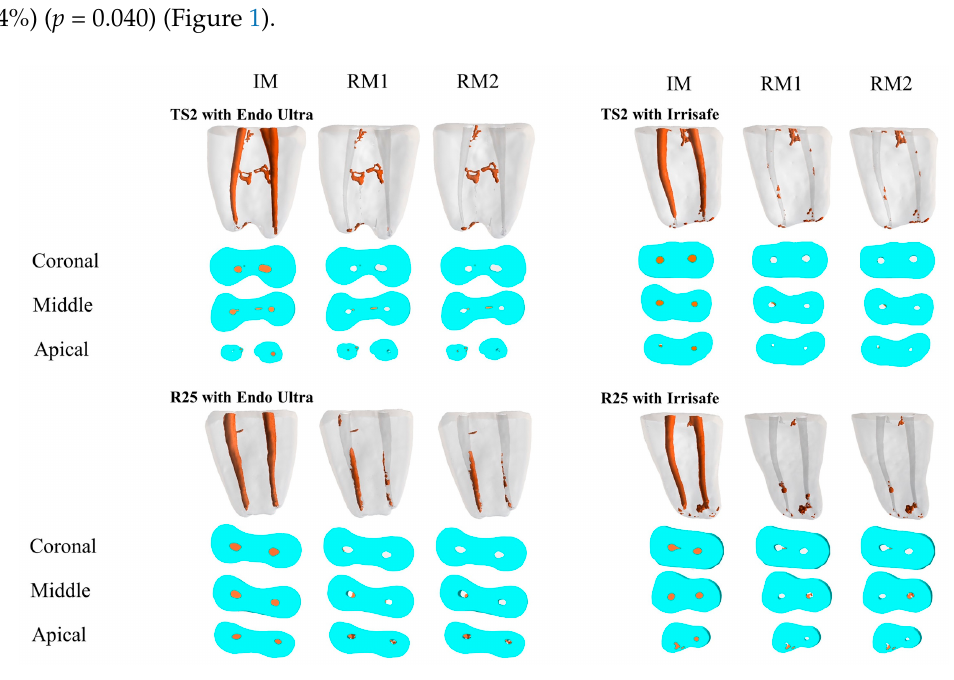
Figure 1. Reconstructed three-dimensional micro-computed tomography (3D µ-CT) images and cross-sections for groups TS2 with Endo Ultra, TS2 with Irrisafe, R25 with Endo Ultra, and R25 with Irrisafe, including initial material (IM), residual material (RM1), and the residual material after passive ultrasonic activation (PUI) (RM2), with the corresponding technique.